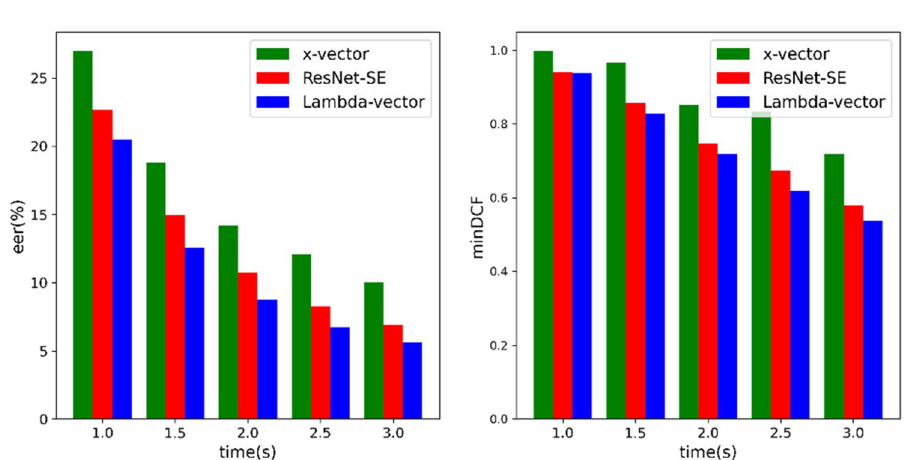
Figure 6. Speaker embedding visualization of x-vector, ResNet-SE and Lambda-vector using t-SNE in the Voxceleb1 test set. Each color represents a speaker, and each point represents a segment with a length of 1 s of audio.